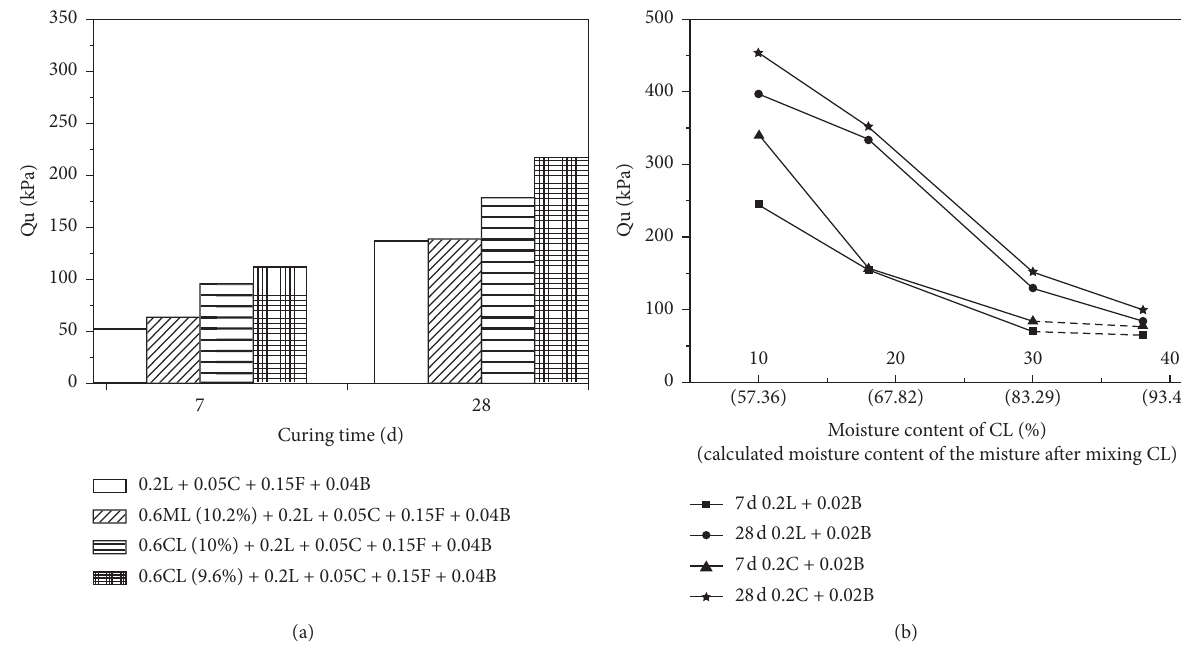
Figure 4: Strength of S/S specimens constructed by skeleton material: (a) skeleton materials (ML, CL, and CH) with approximate moisture content and (b) different moisture contents of the CL.